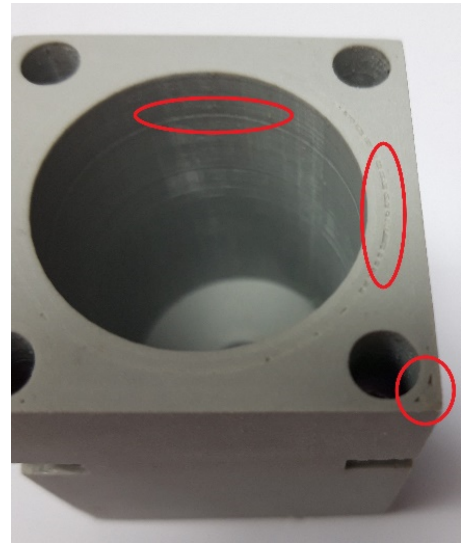
Figure 2. Errors on 3D printed test cylinder.